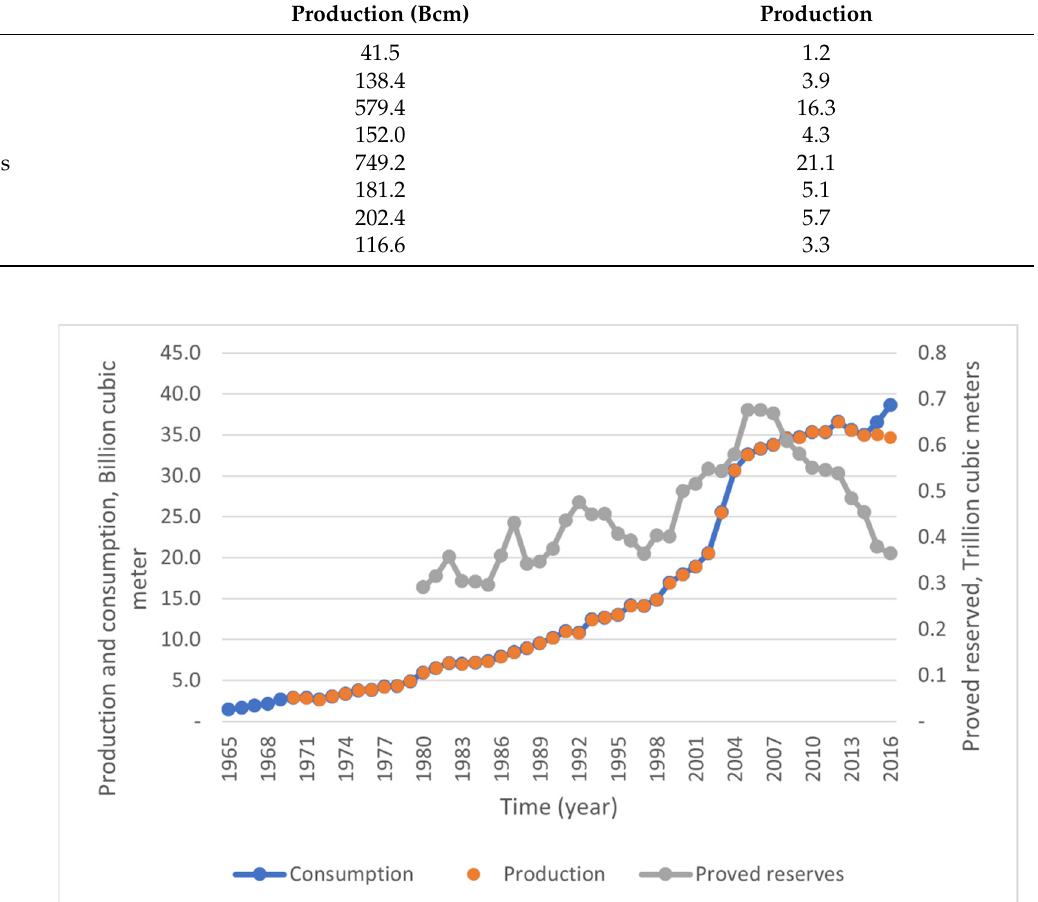
Figure 1. Pakistan’s natural-gas production, reserves, and consumption trend [45]. Table 2. Gas demand and supply scenario from 2020–2028